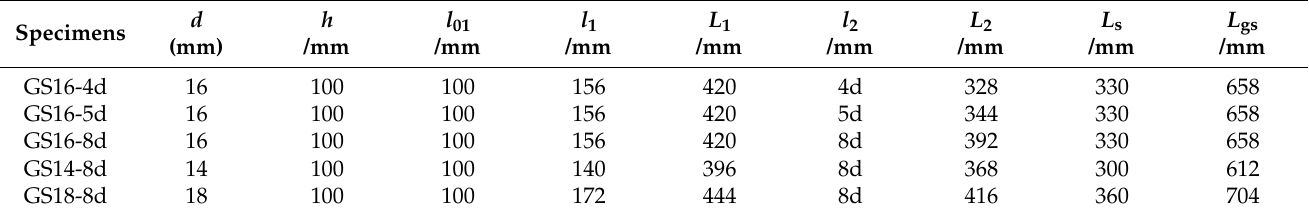
Figure 4. Schematic diagram of specimen. Table 1. Specimen